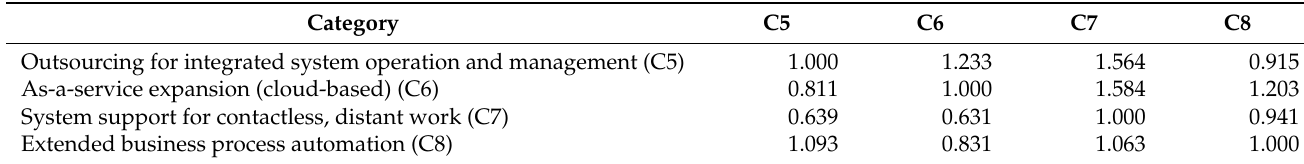
Table 10. Consolidated decision matrix for D2 sub-criteria.